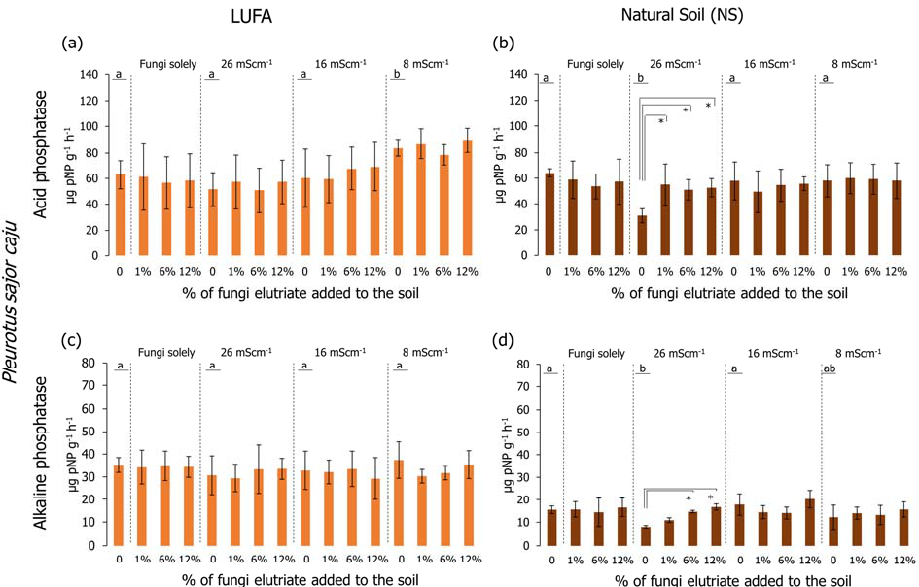
Figure 7. Acid (graphics a , b ) and alkaline (graphics c , d ) phosphatase activity (pNP/g soil/h) at the end of the 96-h germination and seedling growth assay with Lens culinaris in which two different soils at three salinity levels (mS · cm − 1 ) were supplemented with Pleurotus sajor caju rot fungus exudates. Vertical bars represent the standard deviation. Letters indicate homogenous groups between salinity levels solely (Holm-Sidak, p < 0.05). Asterisks (*) indicate significant statistical differences between treatments and the respective salinity treatments (Dunnett’s, p < 0.05).